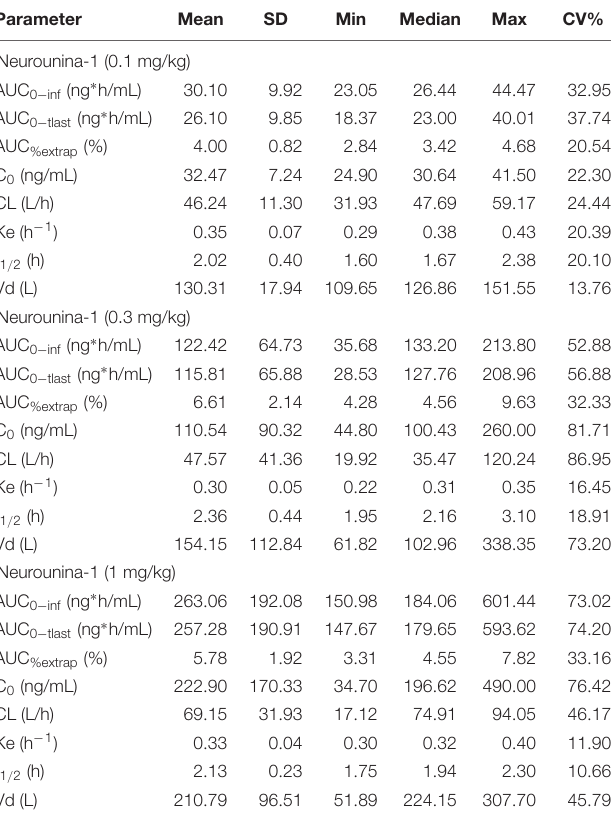
TABLE 4 | Pharmacokinetic parameters after a single intravenous administration of 0.1, 0.3, and 1 mg/kg of neurounina-1 to beagle dogs ( n = 5). Parameter Mean